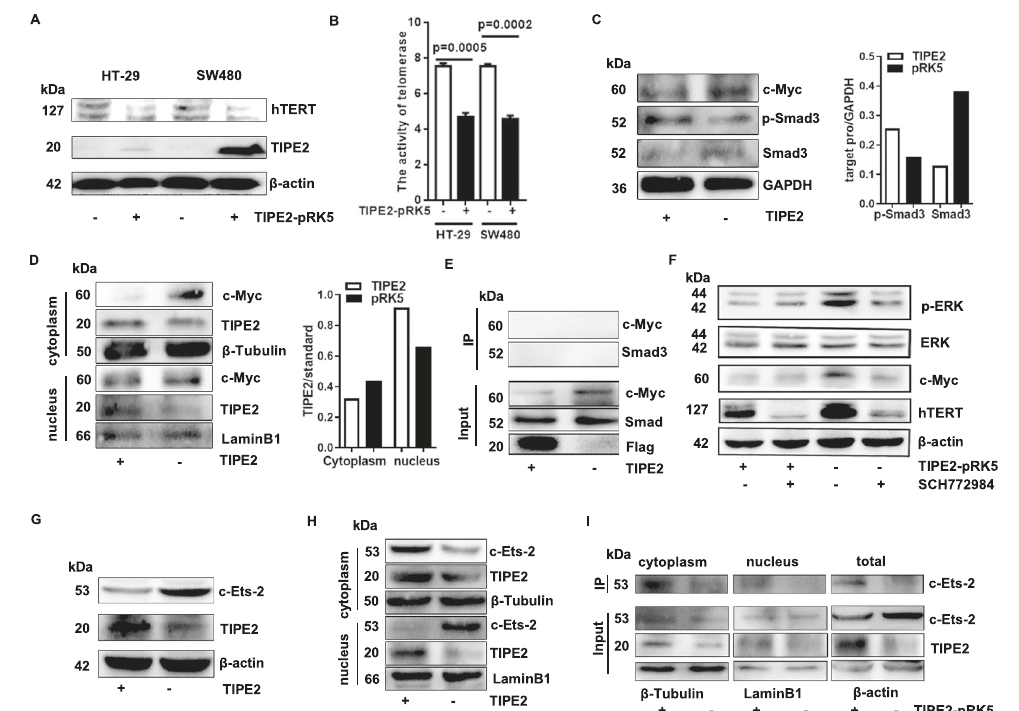
Fig. 2 Tipe2 inhibits telomerase activity through regulating c-Myc and c-Ets-2. A the overexpression of Tipe2 in HT-29 and SW480 cells inhibited the expression of hTERT. B the telomerase activity was signi fi cantly decreased in Tipe2 transfected HT-29 and SW480 cells. C Tipe2 overexpression in HT-29 cells downregulated c-Myc protein while upregulated the phosphorylation level of p-Smad3. Tipe2 downregulated the cytoplasm c-Myc but not nucleus c-Myc ( D ), and didn ’ t bind to c-Myc ( E ). F Tipe2 inhibited the phosphorylation of ERK and the expression of c-Myc. Tipe2 inhibited c-Ets-2 expression ( G ), bound to cytoplasmic c-Ets-2 ( I ) resulting a decreased level of the nucleus c-Ets-2 ( H ) in HT-29 cells. The images were analyzed using ImageJ